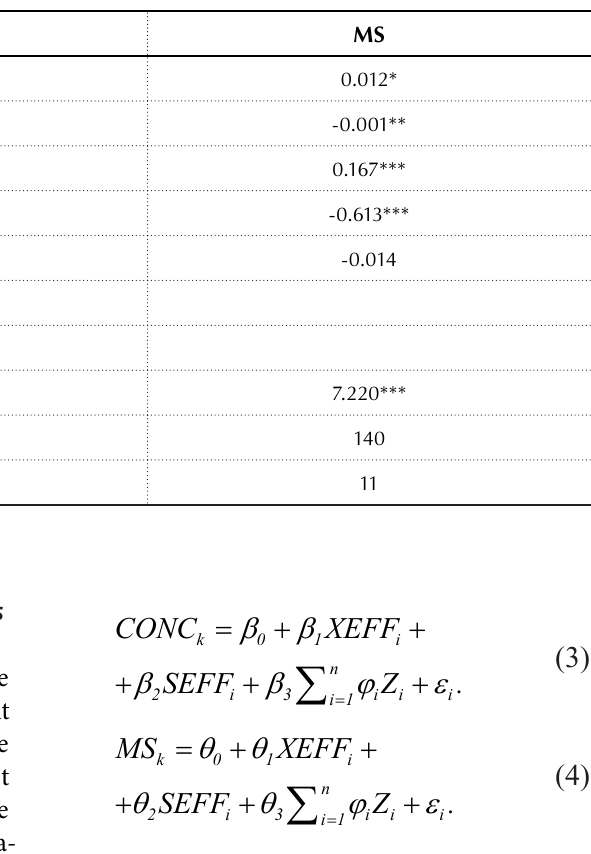
Table 5. Testing for necessary